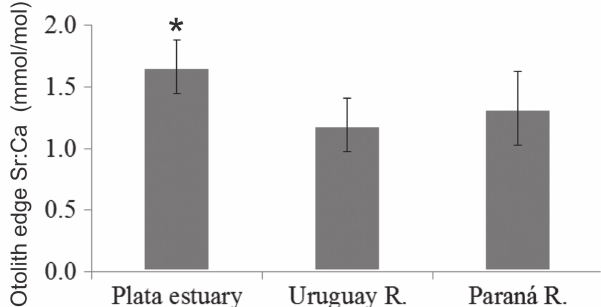
Fig. 3. Otolith edge Sr:Ca ratio of Prochilodus lineatus calculated for freshwater and brackish environments. Asterisks indicate a statistically significant (p<0.05) difference between sampling sites.